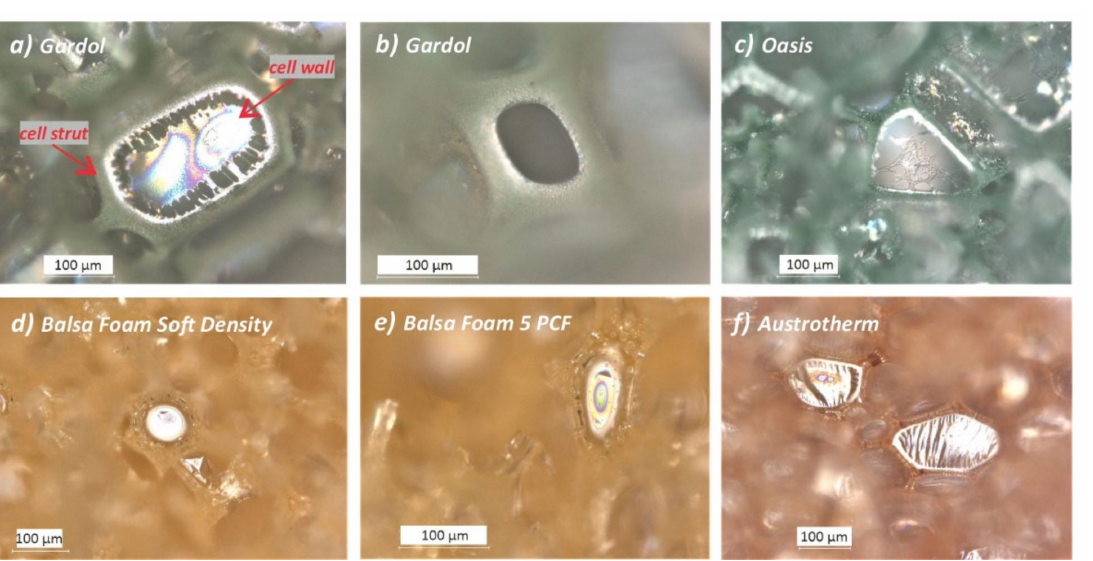
Figure 1. Photomicrographs of different polygonal shapes of cells observed in the “Unaged” Gardol ( a,b ), Oasis ( c ), Balsa foam soft density ( d ), Balsa foam 5 PCF ( e ), and Austrotherm ( f ) foams by digital optical microscope with reflected